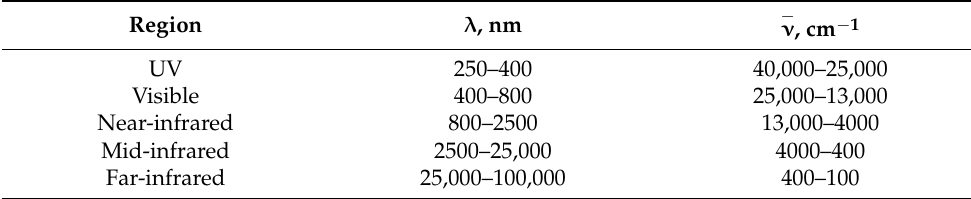
Table 1. Spectral ranges used in molecular spectroscopy [5].